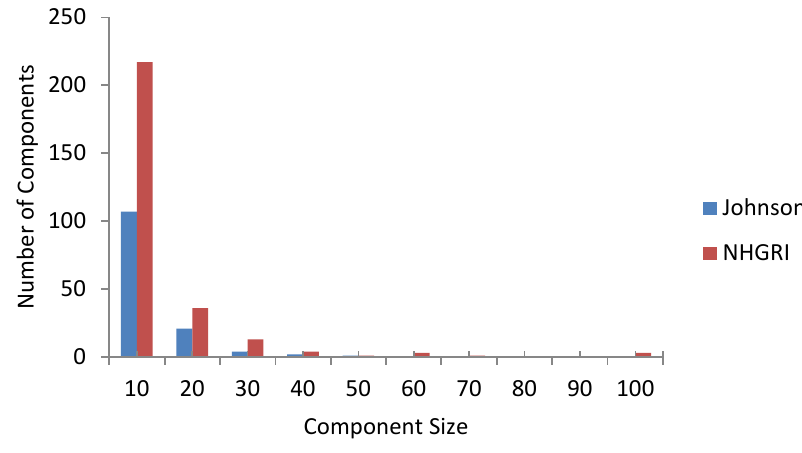
Figure 4. Distribution of the connected component sizes GWAS data sources. The red bars represent the data from NHGRI and blue bars represent data from Johnson’s online dataset. The figure does not include the two biggest connected components; one from NHGRI (3,609 vertices) and one from Johnson’s online dataset (50,161